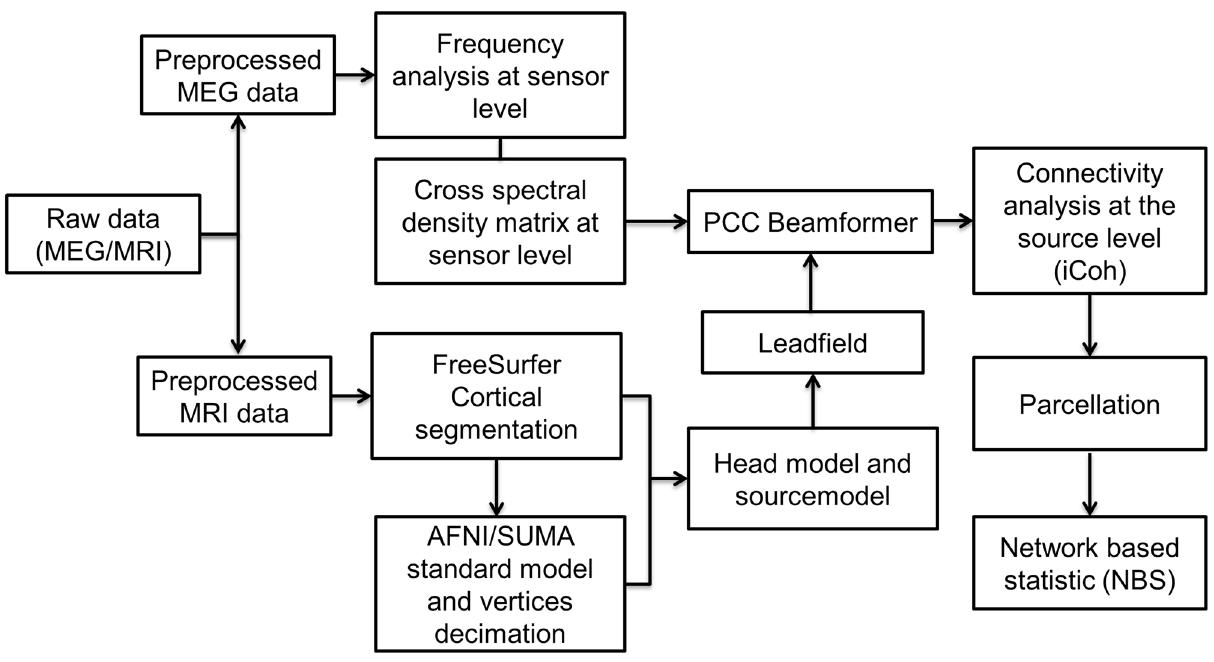
Figure 6. Data analysis